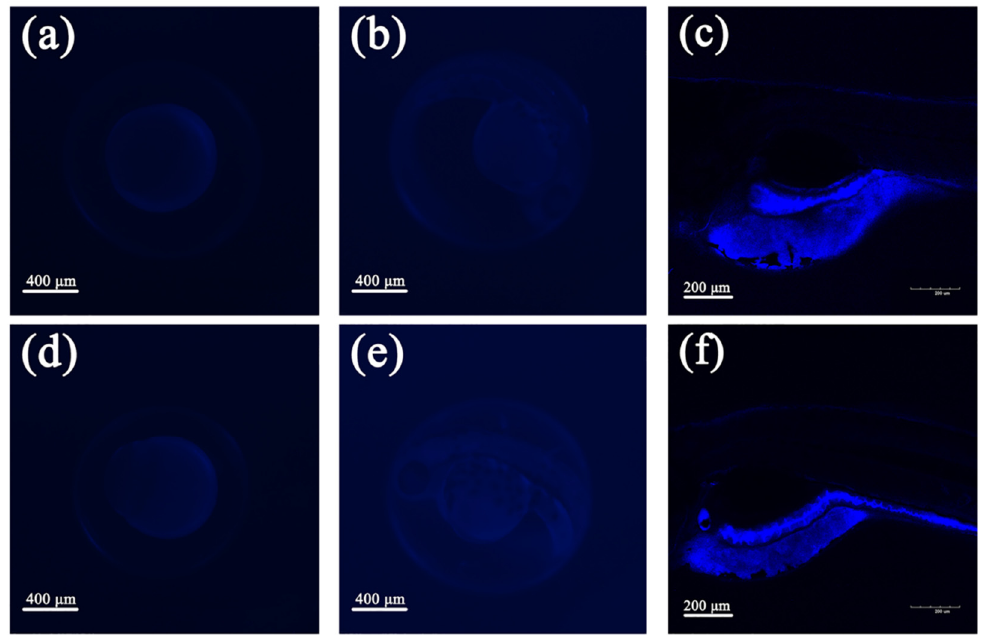
Figure 9. Fluorescence images of zebrafish embryos after soaking in the mixed solutions (15 µ M) of compounds 1 (upper) and 2 (lower) for 3 h at time points: ( a , d ) 9, ( b , e ) 48, ( c , f ) 120 hpf. The excitation wavelength was 359 nm. The collected wavelength range was 430–480 nm.